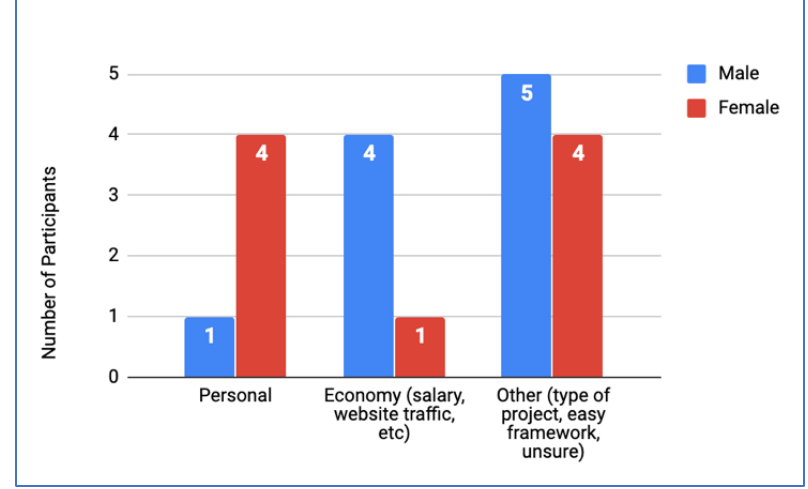
Figure 2. Reasons affecting motivations to learn about accessibility shown by gender. Figure 2. Reasons a ff ecting motivations to learn about accessibility shown by